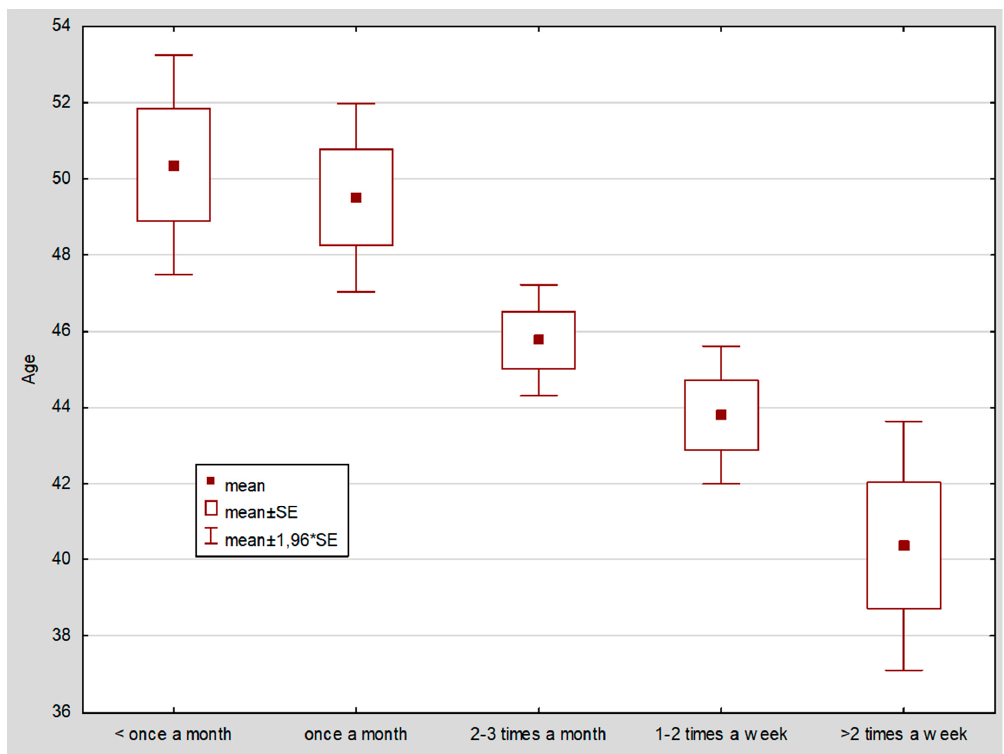
Figure 3. Age vs. purchase frequency during the COVID-19 pandemic ( p = 0.0000) Source: own